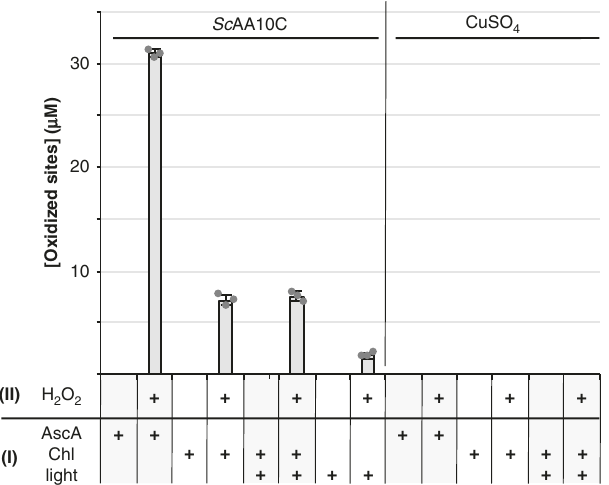
Fig. 4 Anaerobic activation of Sc AA10C by Chl/Light. The experiment consisted of two phases, namely a pretreatment phase (I) followed by an activity test phase (II). Conditions were varied as indicated by the + signs below the graph, as further explained below. All phases were performed under anaerobic conditions, at 25 °C. During phase (I), Sc AA10C (50 µ M; note the high concentration) or CuSO 4 (50 µ M; to assess the occurrence of transition metal-catalyzed non-enzymatic reactions) were incubated with either AscA (100 µ M, i.e., a two-fold molar surplus relative to the LPMO) as positive control or Chl (500 µ M) in sodium phosphate buffer (50 mM, pH 7.0), in sealed Quartz cuvettes, exposed or not to light (visible light, 25% I max , ca. 42 W cm − 2 ). After 10 min of incubation (phase I), the pre-treated sample (50% of fi nal volume) was mixed with a suspension of Avicel (10 g L − 1 fi nal) in sodium phosphate buffer (50 mM, pH 7.0) and, then, H 2 O 2 (200 µ M fi nal) was added when indicated ( “ + ” sign, otherwise replaced by water). Phase (II) reaction mixtures were incubated for 30 min before being heat-treated (100 °C, with shaking at 800 rpm) and fi ltered. Before product quanti fi cation, solubilized cello-oligosaccharides were hydrolyzed by Tf Cel5A, to convert the LPMO products to a mixture of only two oxidized products with a degree of polymerization of 2 and 3 [GlcGlc1A, (Glc) 2 Glc1A], the amounts of which were summed up to yield the concentration of oxidized sites Error bars show ± s.d. ( n = 3, independent experiments). Source data are provided as a Source Data fi